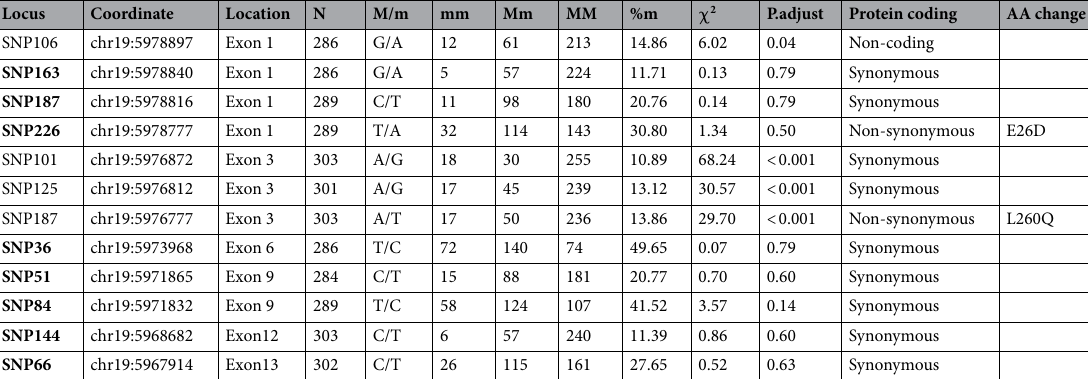
Table 1. Single nucleotide polymorphisms (SNPs) in SERT with minor allele frequency (%m) > 10%. Coordinate refers to the position within the great tit genome on chromosome 19. For each SNP we give the total sample size (N), major/minor alleles (M/m) with sample sizes per genotype and protein coding with associated amino acid (AA) changes. Chi-square ( χ 2 ) statistics for Hardy–Weinberg equilibrium are given with associated significance levels adjusted for false discovery rate (P.adjust). SNPs used for association testing with behavioural traits are depicted in